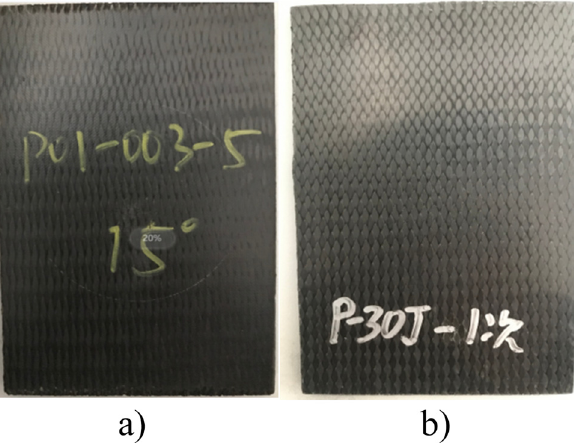
Figure 3: The specimen before testing, ( a ) braided angle of 15°, ( b ) braided angle of